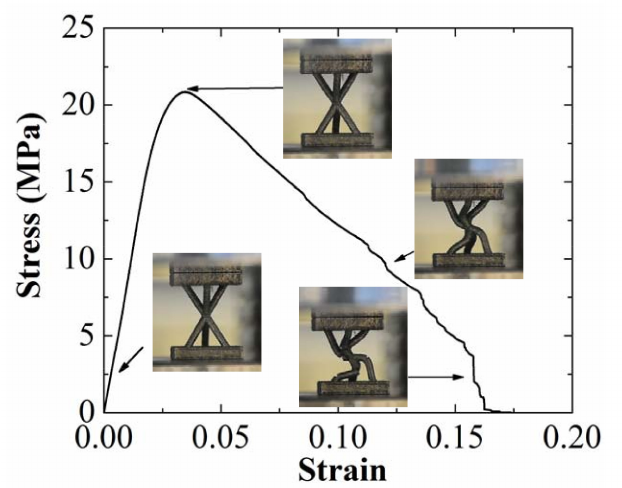
Figure 4. Compressive stress-strain curve of Ti-6Al-4V unit Kagome structure with the video frames at various compression stages.